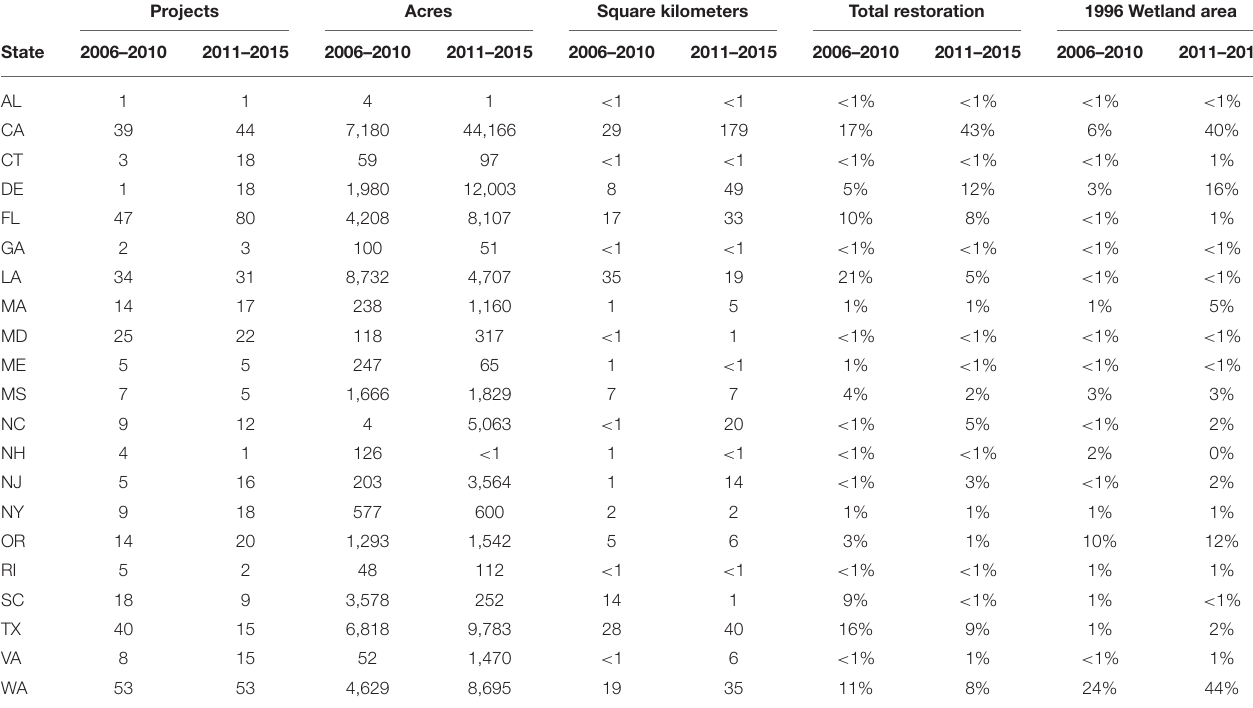
TABLE 3 | Voluntary estuarine restoration efforts from 2006 to 2015. Projects Acres Square kilometers Total